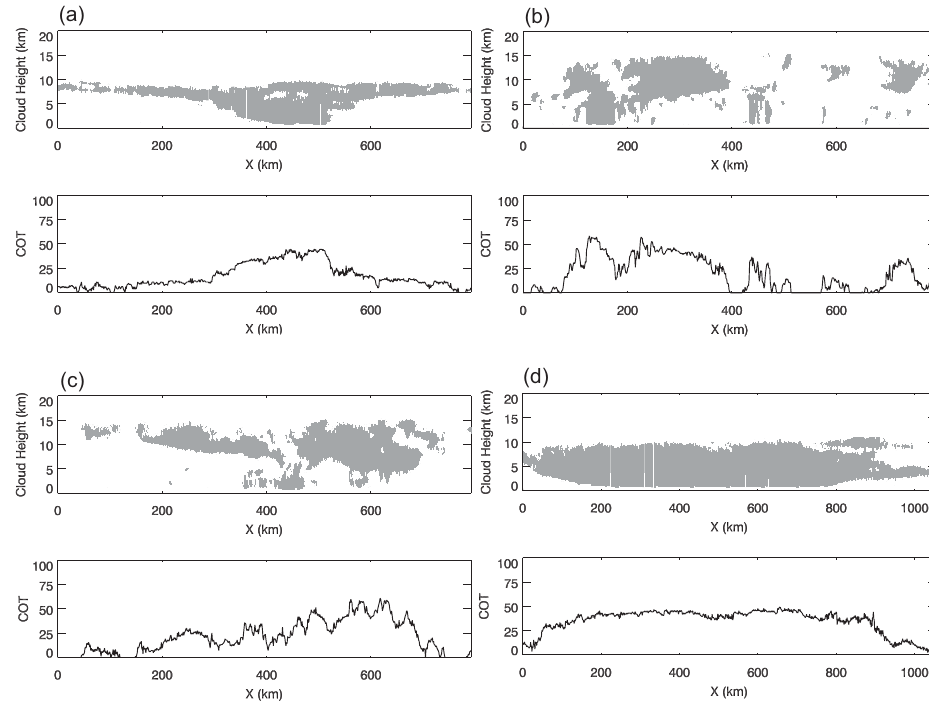
Fig. 5. Distribution of cloud vertical shape and the related COT for (a) CS1, (b) CS2, (c) CS3, and (d) CS4 cloud